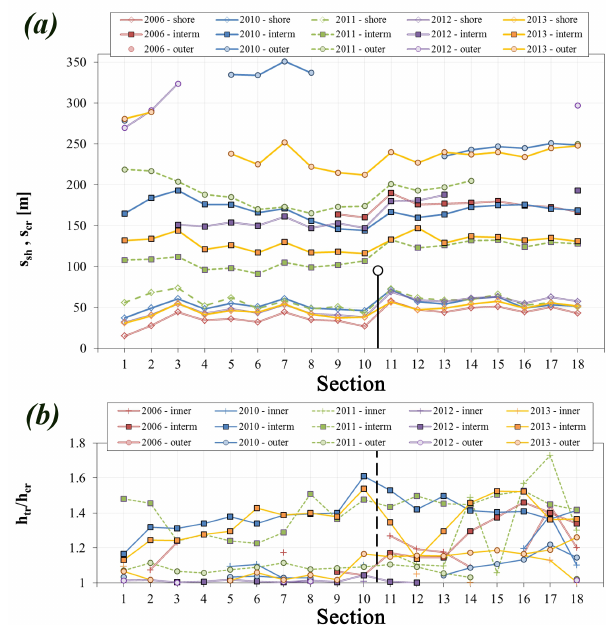
Figure 5. Longshore evolution of bar features: (a) shoreline, middle and offshore bars and (b) ratio between trough and crest depth. The vertical black lines represent the Rotonda